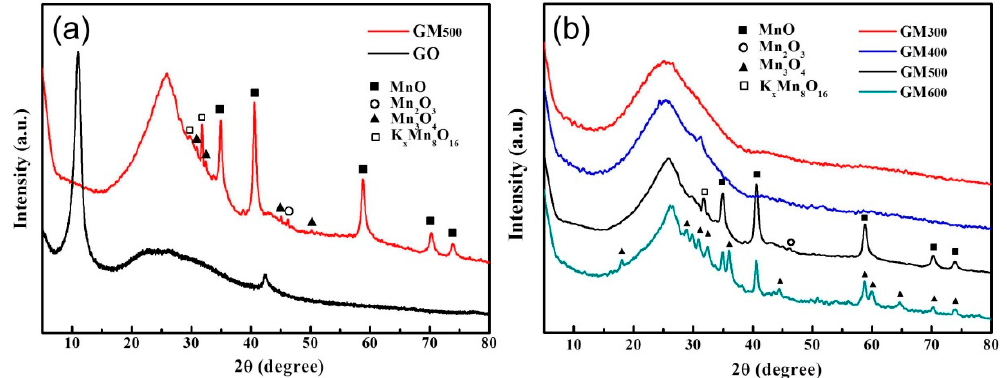
Figure 1. ( a ) X-ray diffraction (XRD) spectra of the graphene oxide (GO) and GM 500 ; ( b) Comparative XRD spectra of GM 300 , GM 400 , GM 500 , and GM 600 (denoted the MnO x / rGO as GM n , where n is the annealing temperature).